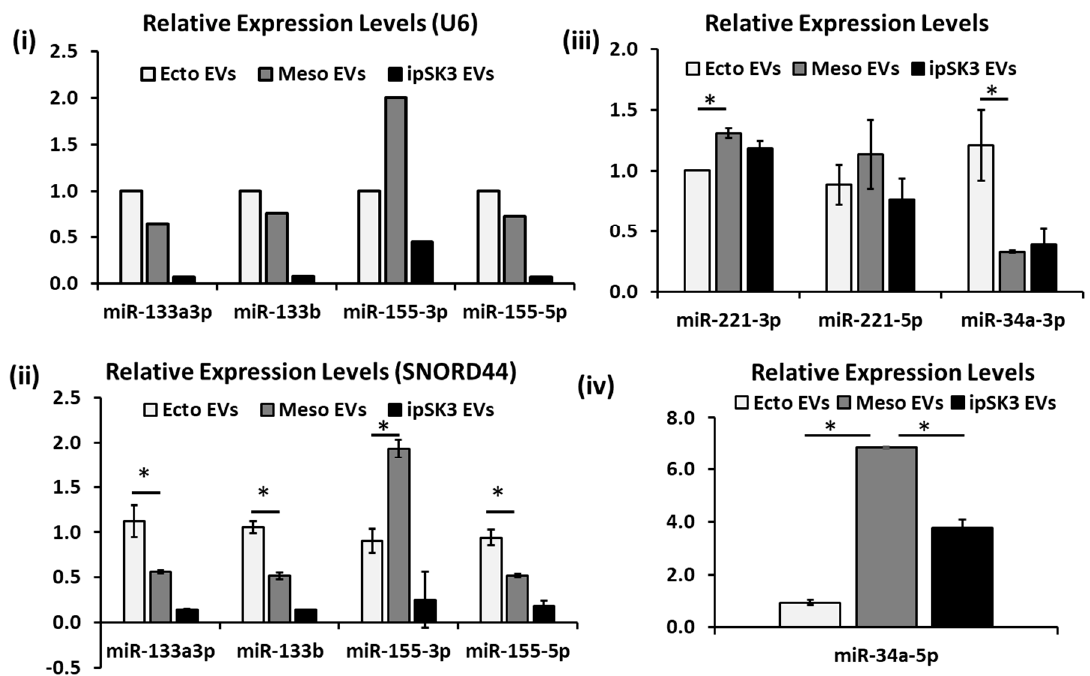
Figure 8. Differential expression of miRNAs in different hiPSC-EV groups. RT-PCR analysis of miR-133 and miR-155 in different EV groups. ( i ) Normalized to U6; ( ii ) normalized to SNORD44 ( n = 3). ( iii ) RT-PCR analysis of miR-34a-3p and miR-221 in different EV groups (normalized to SNORD44, n = 3). ( iv ) RT-PCR analysis of miR-34a-5p in different EV groups (normalized to SNORD44, n = 3). * indicates p < 0.05.